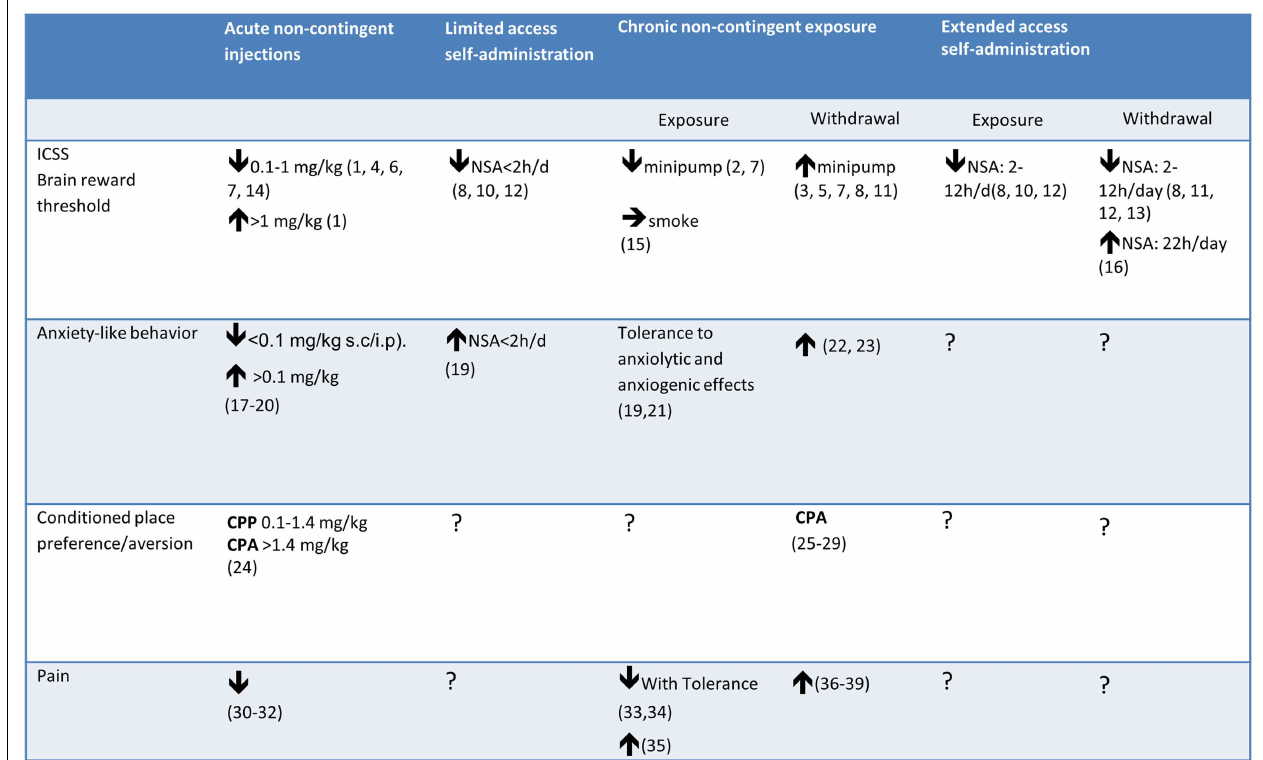
FIGURE 1 | Effects of acute/chronic non-contingent nicotine exposure, limited/extended access to nicotine self-administration (NSA), and withdrawal from chronic nicotine on measures of reward threshold (ICSS), anxiety-like behavior, and reward (CPP) or aversion (CPA) . Note that the effect of withdrawal from chronic nicotine on the reward thresholds differed depending on the type of nicotine delivery. 1. Huston-Lyons and Kornetsky (1992), 2. Bozarth et al. (1998a), 3. Bozarth et al. (1998b), 4. Bespalov et al. (1999), 5.Watkins et al. (2000a), 6. Harrison et al. (2002), 7. Cryan et al. (2003), 8. Kenny and Markou (2005), 9. Kenny and Markou (2006), 10. Kenny et al. (2009), 11. Johnson et al.